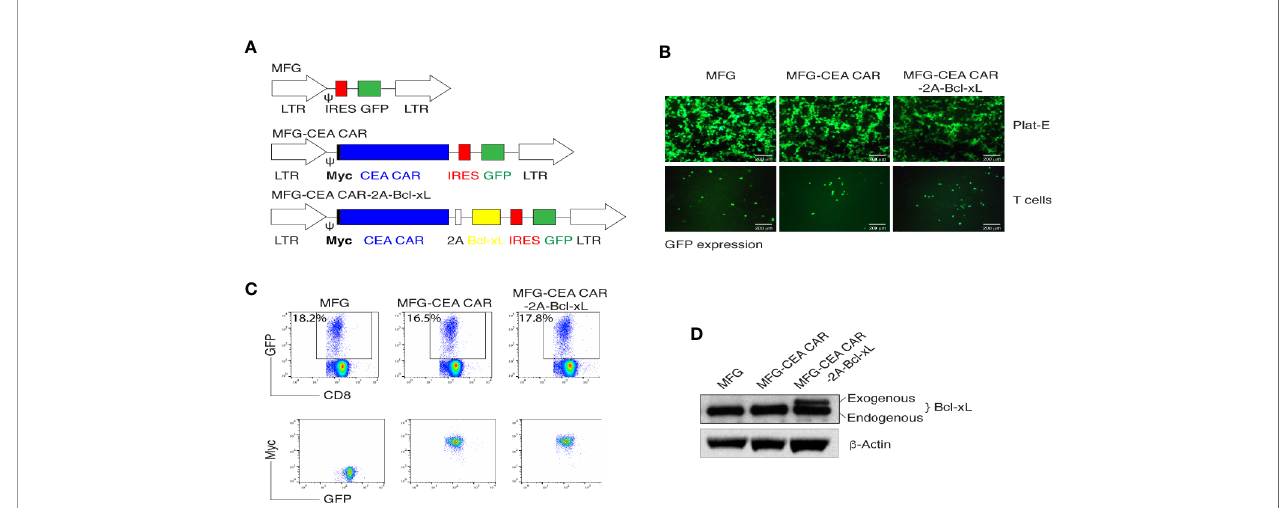
FIGURE 1 | In vitro generation of carcinoembryonic antigen (CEA) chimeric antigen receptor T (CAR-T) cells. (A) Schematic representation of the retroviral constructs MFG, MFG-CEA CAR, and MFG-CEA CAR-2A-Bcl-xL. CEA CAR is Myc tagged; Y , packaging signal; 2A, picornavirus self-cleaving 2A sequence; LTR, Long terminal repeats. (B) The packaging Plat-E cells (upper panel) and MFG-transduced CD8 + T cells (lower panel) were visualized by fl uorescence microscopy (scale bars: 200 m m). (C) CD8 + T cells were transduced with the retroviral constructs and GFP + CD8 + T cells (upper panel) or GFP + Myc + T cells gated on GFP + CD8 + populations were analyzed by fl ow cytometry. (D) GFP + CD8 + T cells were sorted, and the cell lysates were determined for the expression of Bcl-xL and b -actin by western blotting. All data are representative of three independent